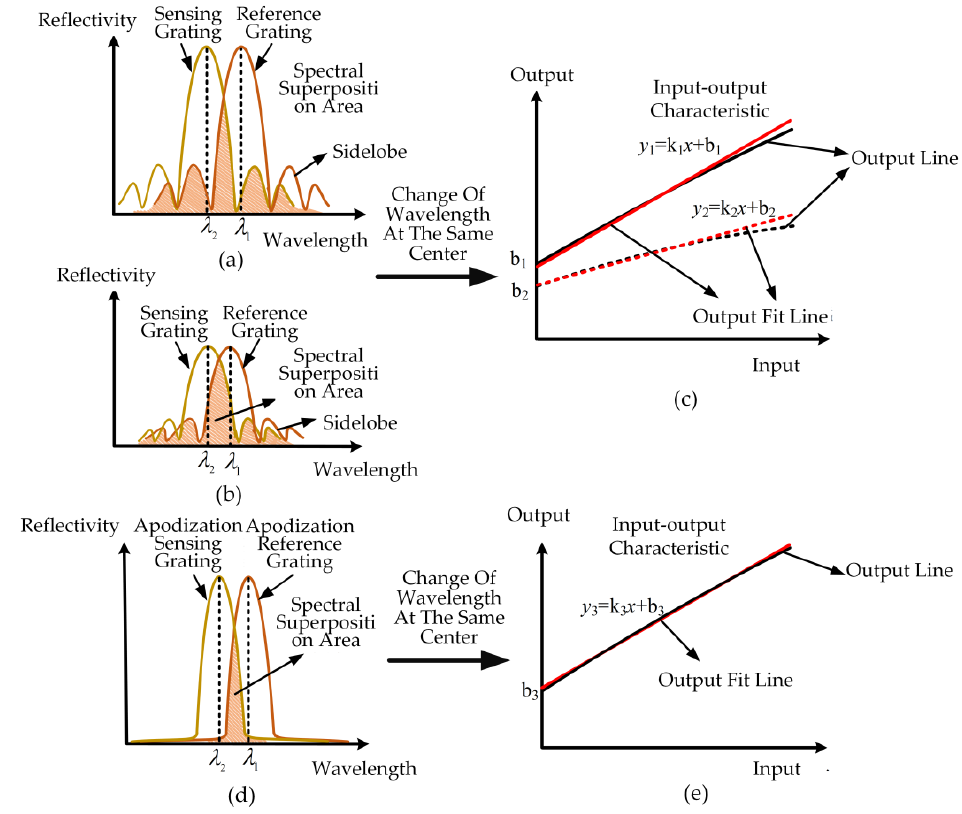
Figure 1. Effect of spectral morphology on sensor characteristics. ( a , b ) Schematic of the spectral superposition area at different reflectivities and bandwidths and ( c ) corresponding input-output curve. ( d ) Schematic of the spectral superposition area after toe cutting and ( e ) corresponding input-output